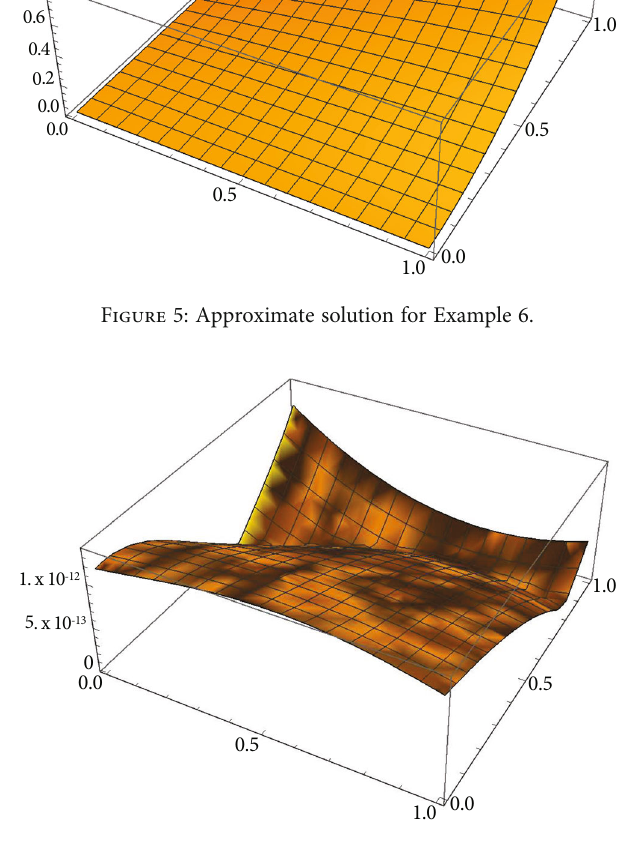
Figure 6: Absolute error for Example 6.